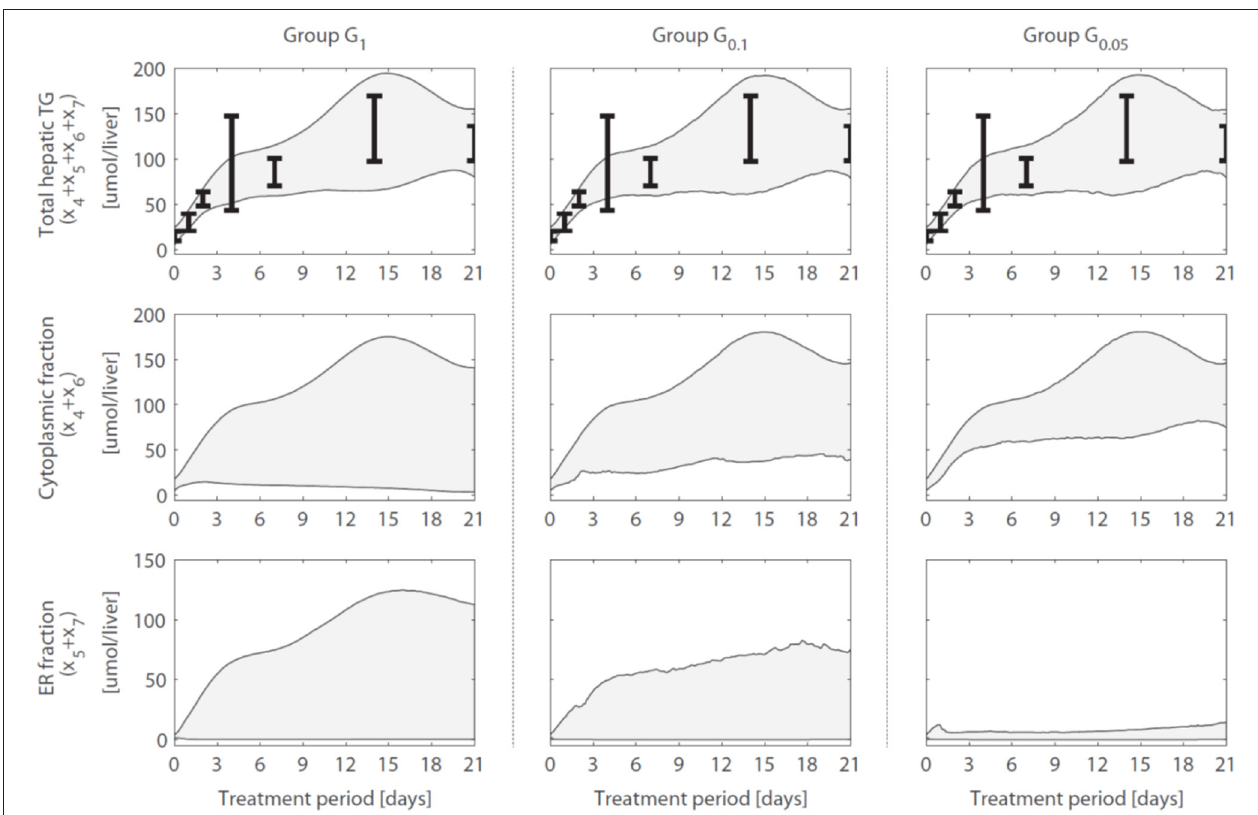
FIGURE 5 | Hepatic triglyceride fluxes are increased and especially stored in the cytosolic fraction. Trajectories of the total hepatic TG content ( y 1 = x 4 + x 5 + x 6 + x 7 ), as well as its subdivision into cytosolic ( x 4 + x 6 ) and endoplasmic reticulum ( x 5 + x 7 ) fractions, are displayed for different groups of solutions. The experimental data of the total hepatic TG content (the error bars represent the standard deviation of the data) was included in the optimization procedure (linked to output y 1 ) and all groups describe this data adequately. When only the metabolic data was used to calibrate the model (group G 1 ), the distribution of the total TG content between the cytosolic fraction (TG in lipid droplets) and ER fraction (TG transferred to nascent VLDL could not be estimated precisely (left column). When including the gene expression data, model results showed that the increased TG pool is especially stored in the cytosol, rather than transferred to nascent VLDL (middle and right column). The solutions with the highest correlation between parameter trajectories and temporal gene expression ( G 0.05 , right column) yielded the most precise estimates. The shaded areas indicate the 95 % confidence intervals of the model estimates.